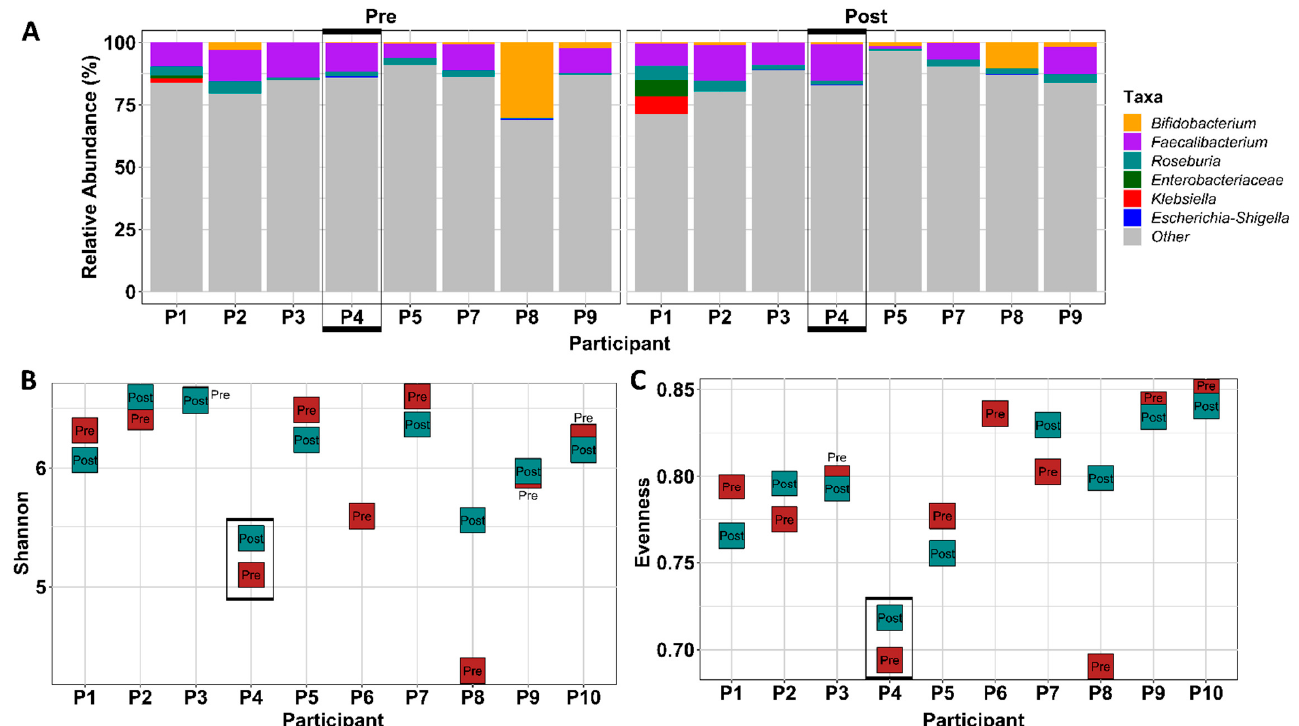
Figure 6. Fecal microbiota transplant (FMT) donor selection informed by relative abundance and alpha diversity. Relative abundance of three health-associated and three inflammation-associated genera were analyzed. Participant four exhibited an increase in Faecalibacterium from baseline to 12 weeks (ns) ( A ). Alpha diversity as measured by Shannon ( B ) and Evenness ( C ) indices increased from baseline to 12 weeks in participant four (ns).